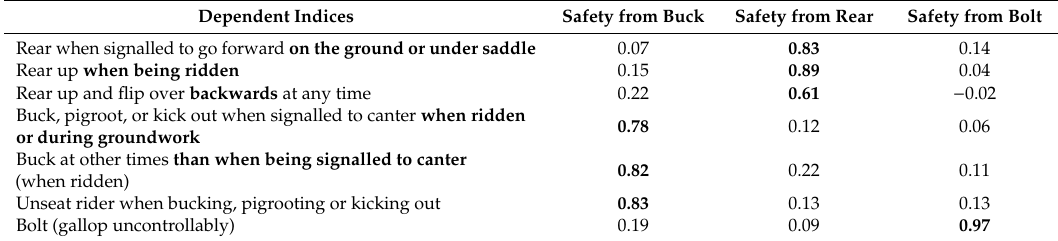
Table 1. Parallel analysis of dependent indices showing loading values with those reaching > 0.49 grouped together as three rotated components (RC) and named based on categorization as Equitation (E) related components (values > 0.49 displayed in